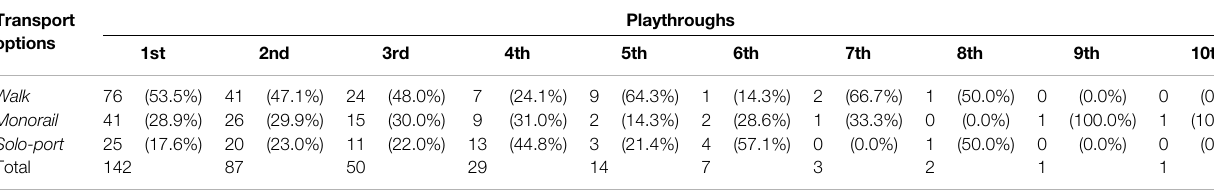
TABLE 3 | Transport choices by playthrough.